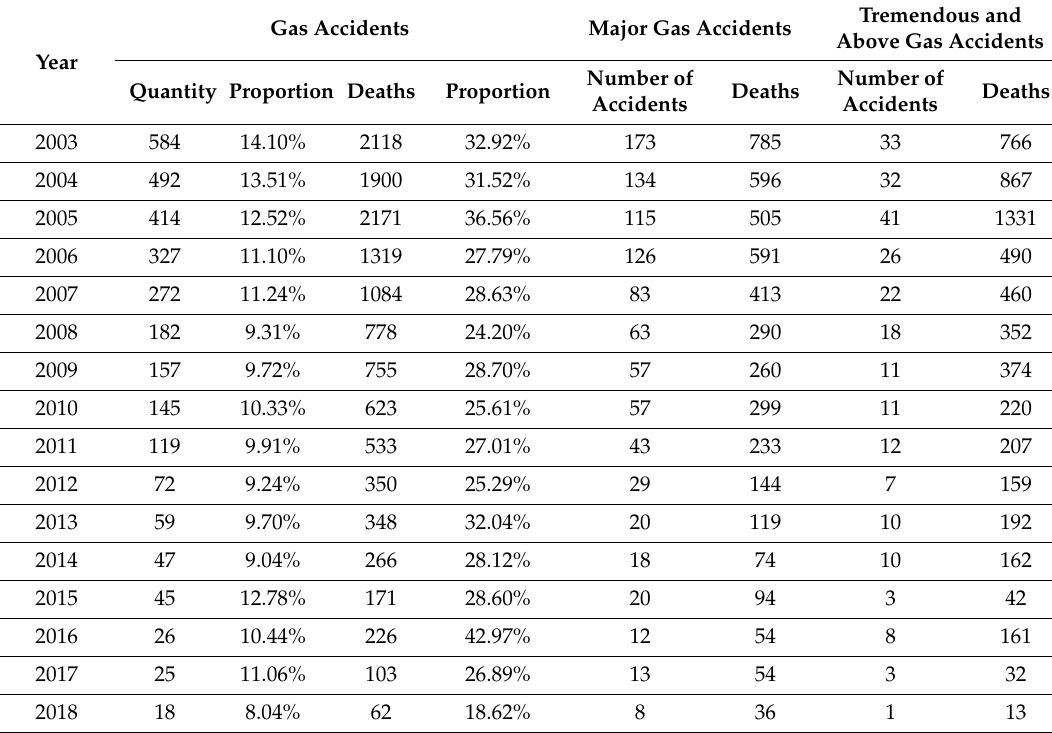
Table 1. Statistics of gas accidents from 2003 to